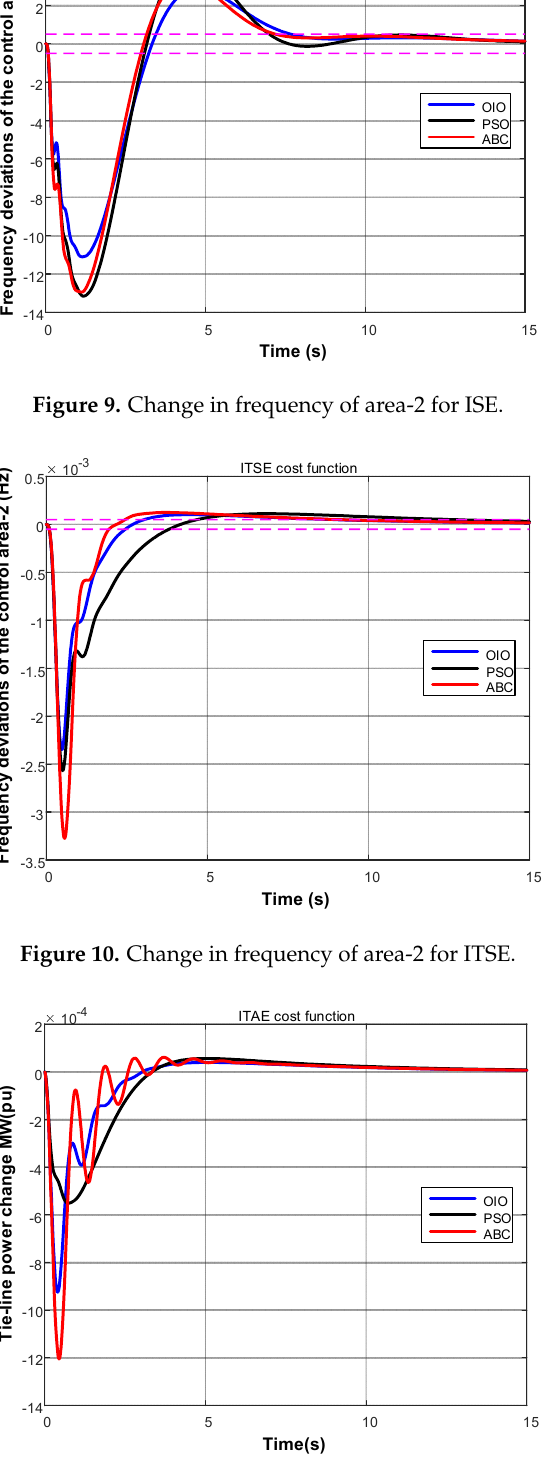
Figure 11. Change in tie ‐ line power for ITAE.